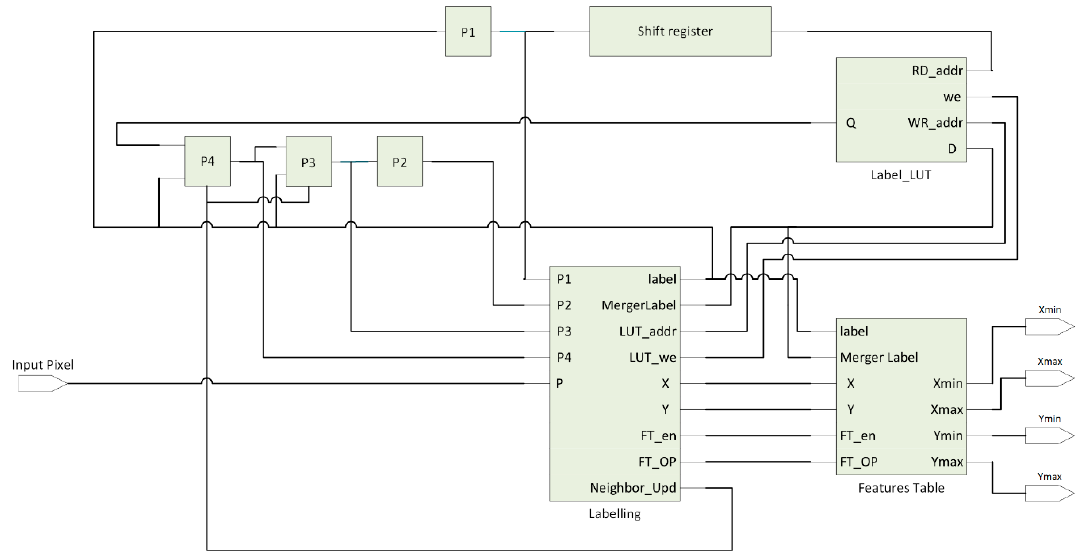
Figure 3. Single pass image segmentation architecture.